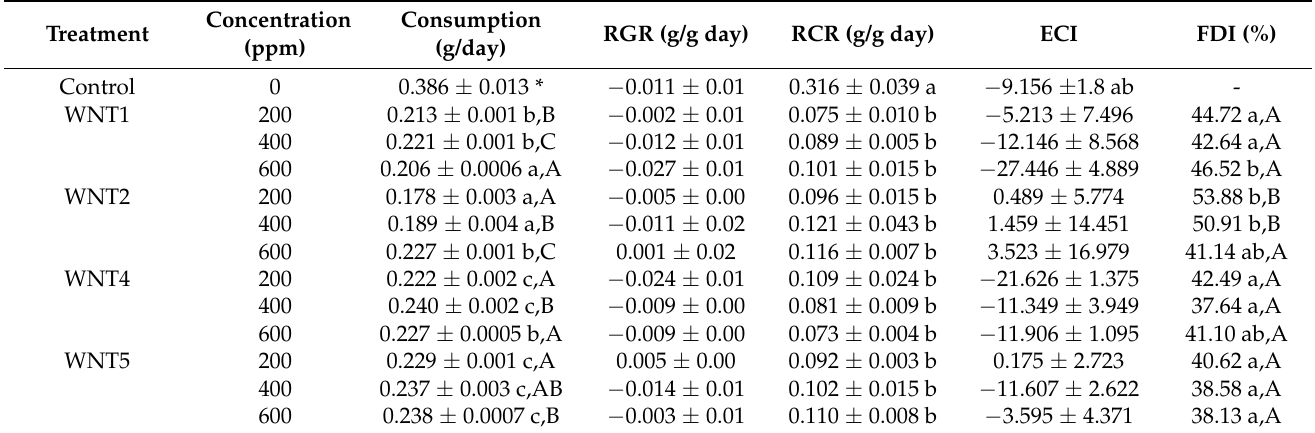
Table 4. Mean ± SE of data for RPW larvae that were treated with thymol derivatives.